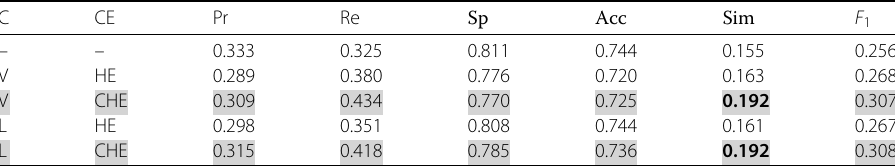
Table 3 Evaluation results for the predicted masks of the GMM generated of preprocessed frames C CE